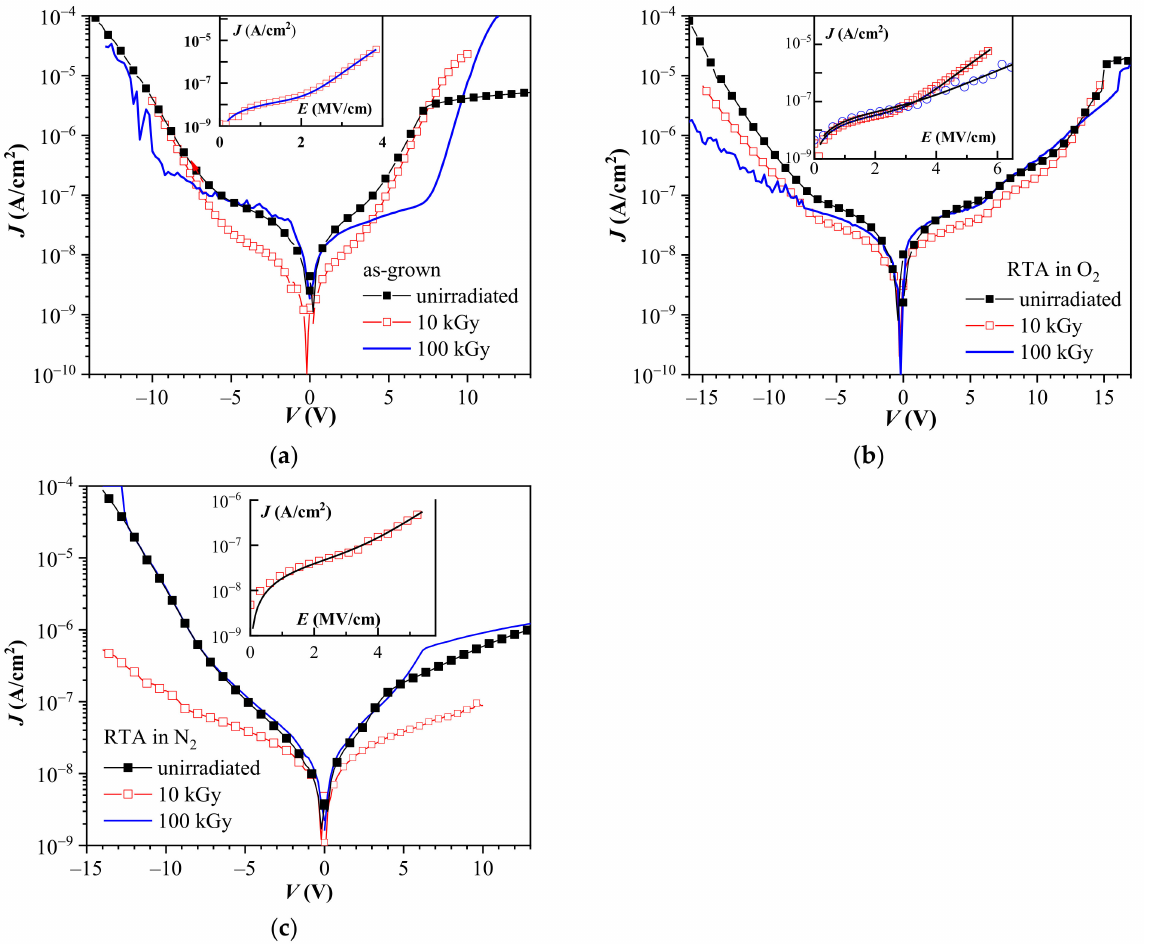
Figure 6. The impact of gamma radiation on the leakage current characteristics of as-grown ( a ) annealed in O 2 ; ( b ) annealed in N 2 ; ( c ) stacks. The insets represent fits of the experimental data to Equation (1) for 10 kGy ( a ) 10 and 100 kGy ( b ) 10 kGy ( c